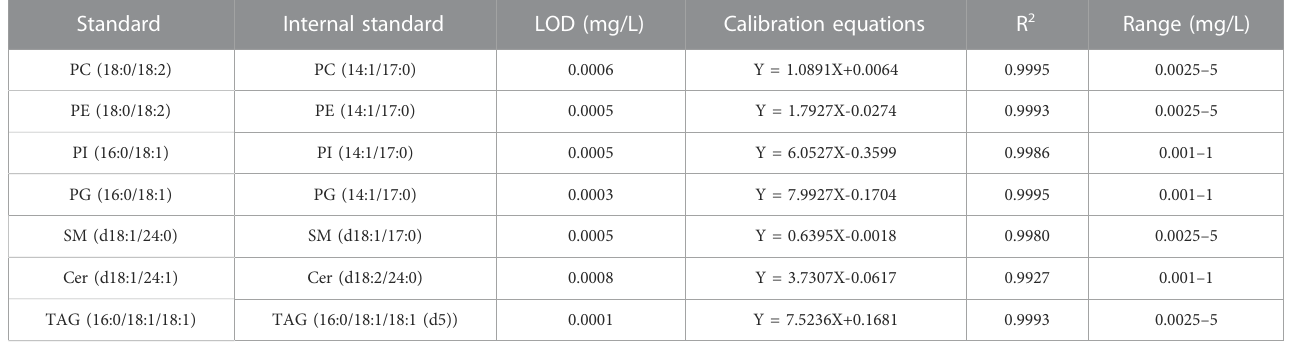
TABLE 3 LOD, LOQ, linearity of lipid standards and corresponding internal standards. Standard Internal standard LOD (mg/L) Calibration equations